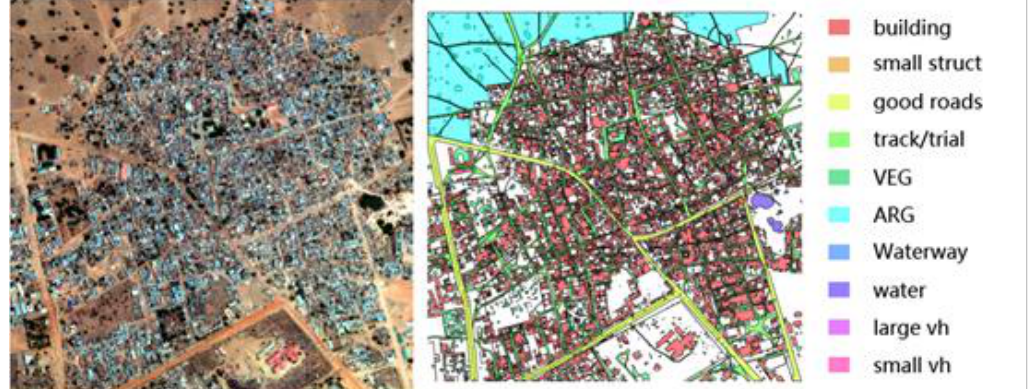
Fig.2 Segmentation result with manual ground truth